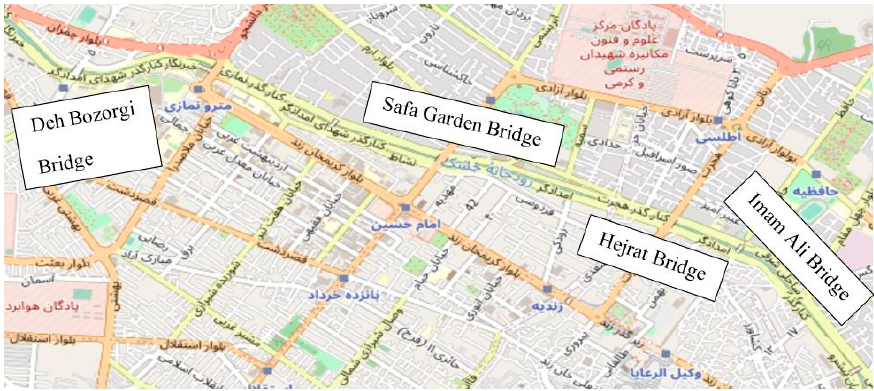
Figure 9. A map of Imam Ali Bridge to Deh Bozorgi Bridge downloaded from OSM.